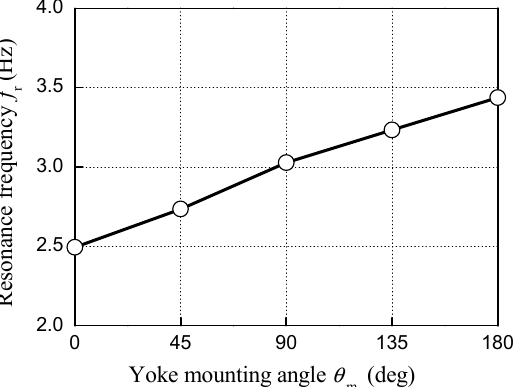
Figure 10. Relationship between yoke mounting angle and resonant frequency.